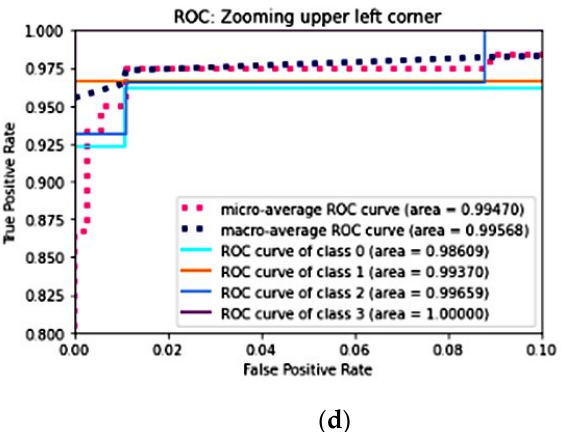
Figure 9. Classification results for the subjects in the PhysioNet dataset (test data) for subject-independent classification. ( a ) Confusion matrix. The model achieves 100% accuracy for right fist MI. ( b ) Precision–recall curve. ( c ) ROC curves. ( d ) Zoomed-in view of the upper left corner of the ROC curve plot. Precision–recall curve and ROC plot also validate these results.